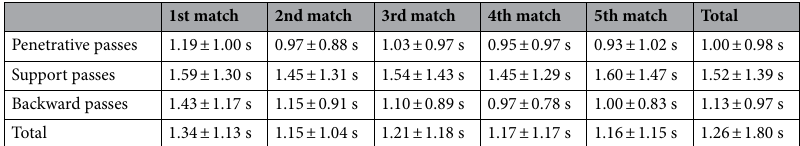
Table 1. Mean and standard deviation of the time that the passing opportunities were available per match. The values are presented in